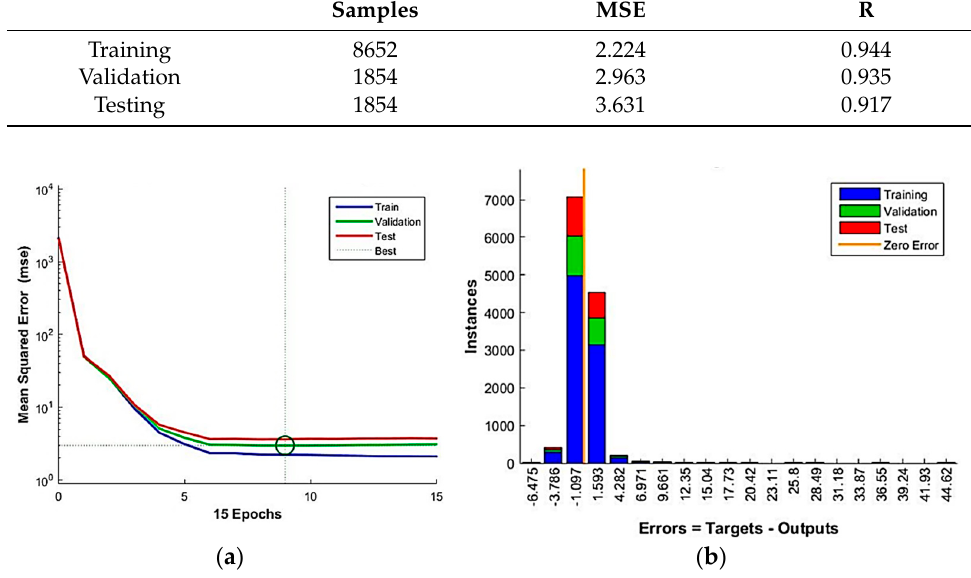
Figure 8. ( a ) Training process and ( b ) error histogram of the employed artificial neural network.